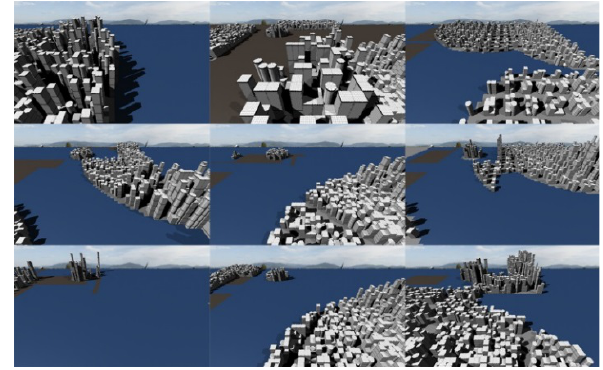
Figure 8. Generation 30 of an IGA run